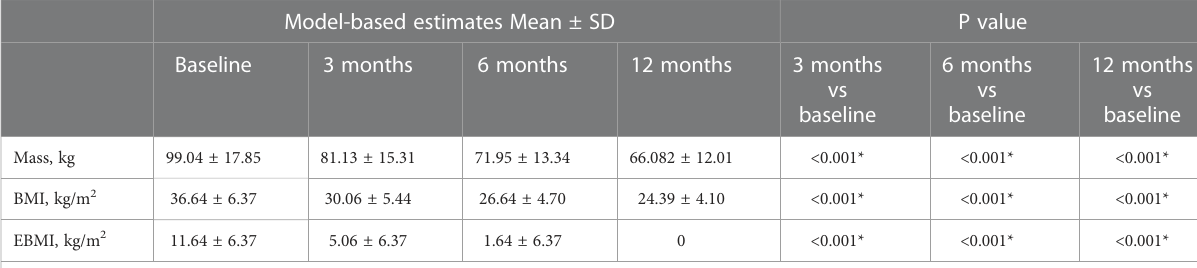
TABLE 2 Comparison of preoperative and postoperative weight indexes at 3, 6 and 12 months a .